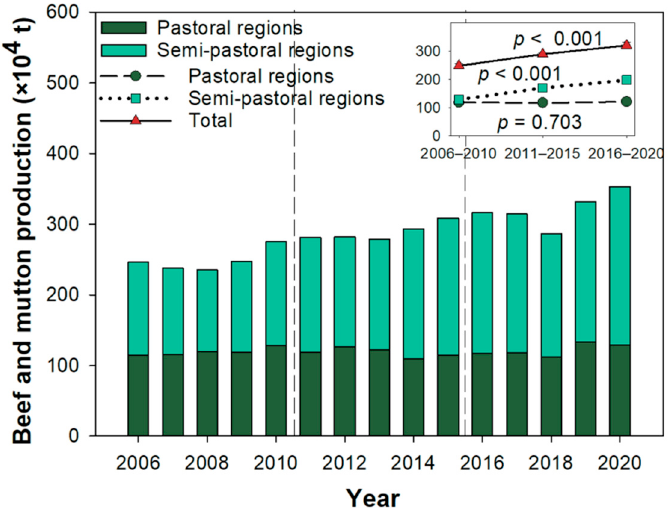
Figure 5. Beef and mutton production in pastoral and semi-pastoral regions of China from 2006 to